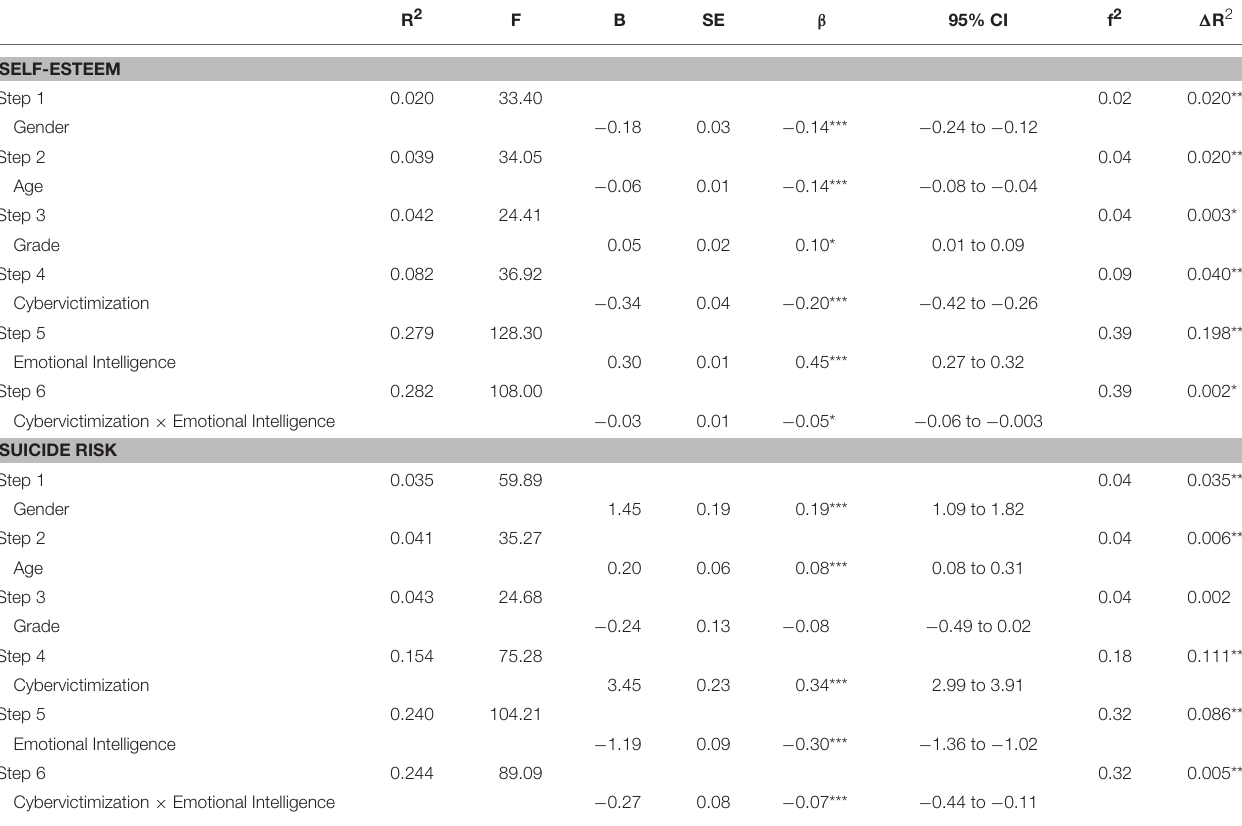
TABLE 2 | Moderated hierarchical regression analyses for self-esteem and suicide